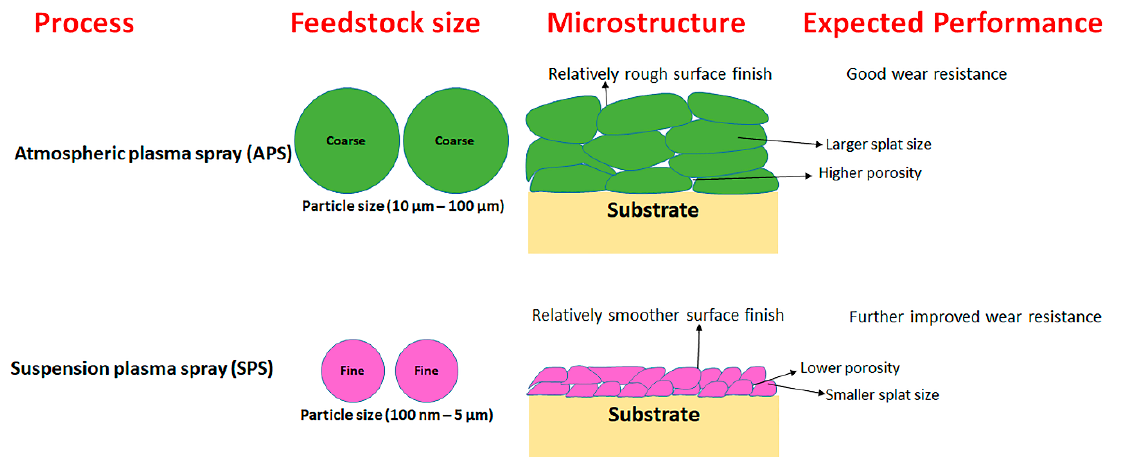
Figure 1. Schematic of comparison of feedstock–microstructure–property relationships in APS and SPS coatings.